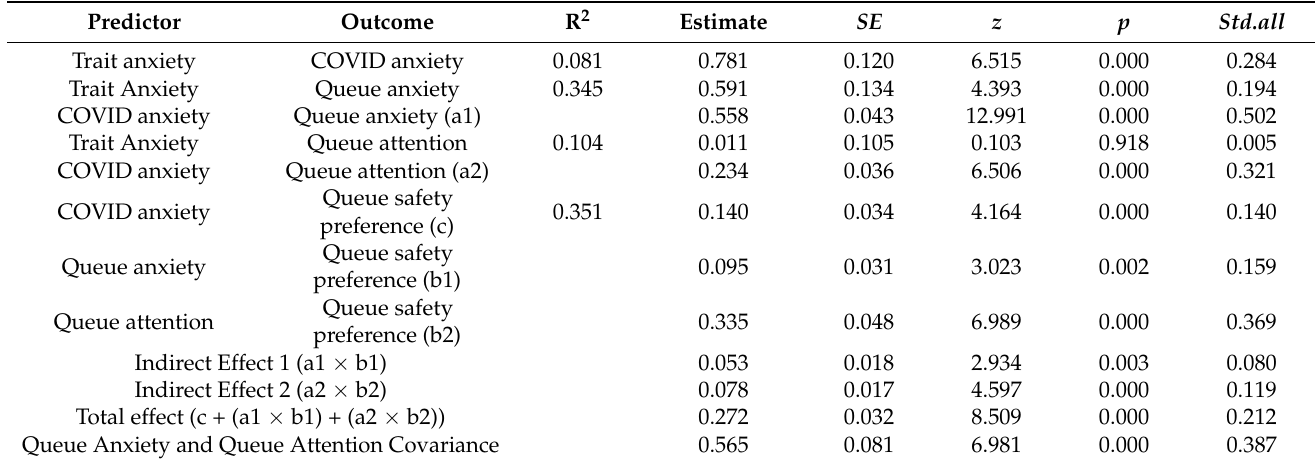
*** p < 0.001. Table 5. Queue anxiety and attention path